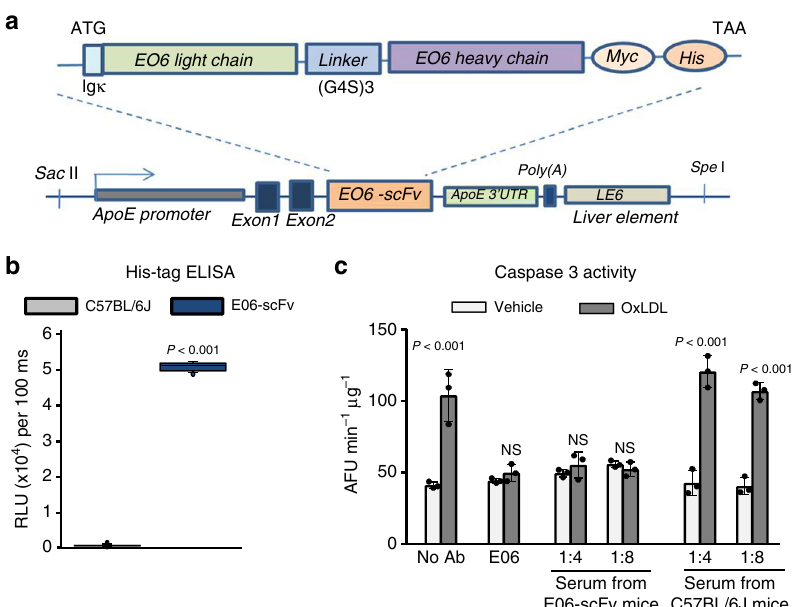
Fig. 2 Generation of E06-scFv transgenic mice. a E06-scFv transgene structure. The transgene consists of a fusion protein of the heavy- and light-chain variable domains, which constitute the antigen recognizing portion of the natural antibody E06. The domains are covalently linked by a fl exible peptide linker. The transgene is expressed under the control of the ApoE promoter. Reproduced from Que et al. 38 with permission. b Quanti fi cation of E06-scFv in the serum of C57BL/6 J and E06-scFv 5-month-old male mice as determined by ELISA. C57BL/6 J n = 5, E06-scFv n = 6. Data were analyzed by Rank Sum test. c E06-scFv prevents the pro-apoptotic effect of OxLDL. Osteoblastic cells obtained from neonatal calvaria were pre-treated for 1 h without (no Ab), or with E06 (2 µ g/ml), or with serum from E06-scFv or C57BL/6 J mice at the indicated dilutions (1:4, 1:8). Serum from 4 mice (per genotype) was pooled for this analysis. Caspase 3 activity was then measured 6 h after addition of OxLDL (50 µ g/ml). All measures were performed in triplicate cultures. Essentially identical results were obtained in a separate experiment. Data were analyzed by ANOVA; the p values re fl ect comparison to the respective vehicle. Data shown represent the mean (±SD). AFU: Arbitrary fl uorescence units